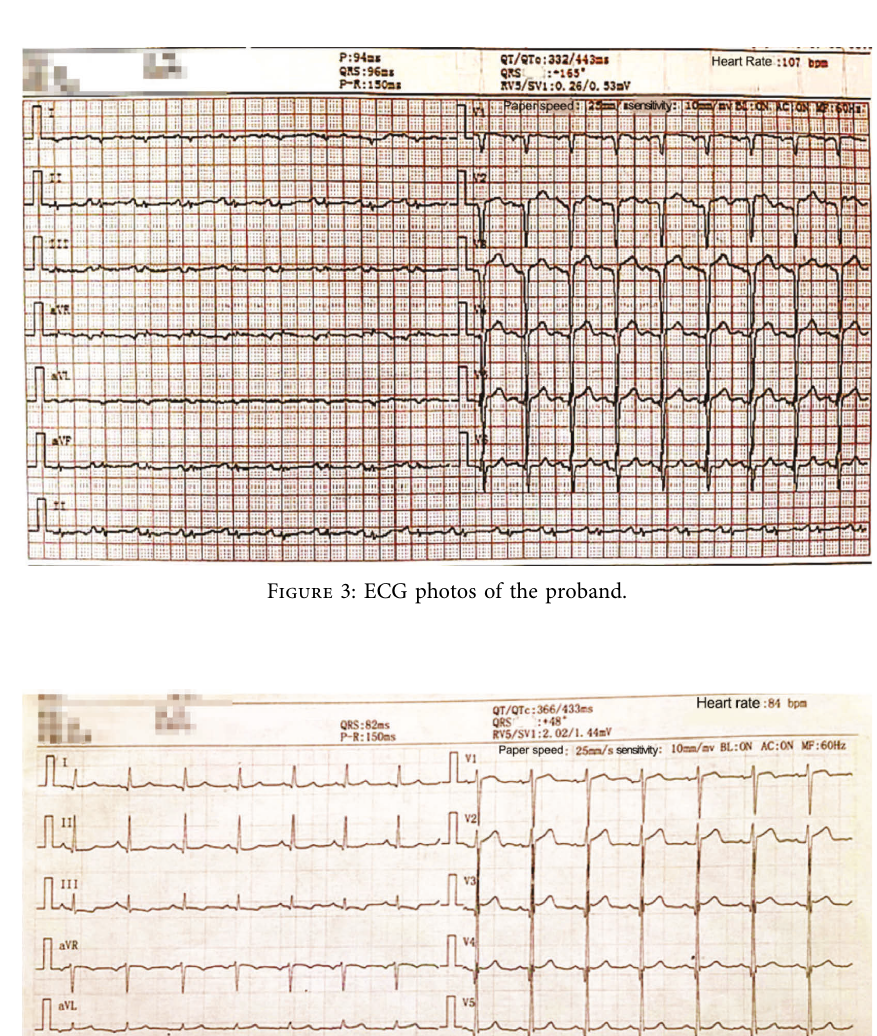
Figure 2: Peak atlas of the TTN gene mutation sequencing.